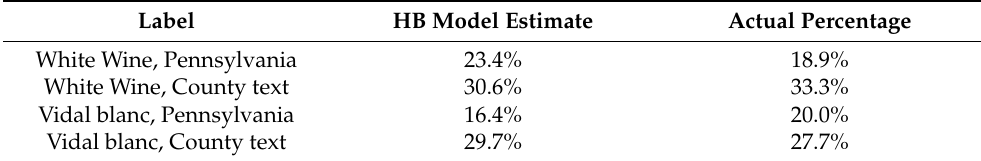
Table 3. Comparison of the holdout task percentages found compared to the Hierarchical Bayes (HB) model estimate for the entire consumer population ( n = 1011). All the presented wine labels in the holdout task used cursive font and the more embellished image.